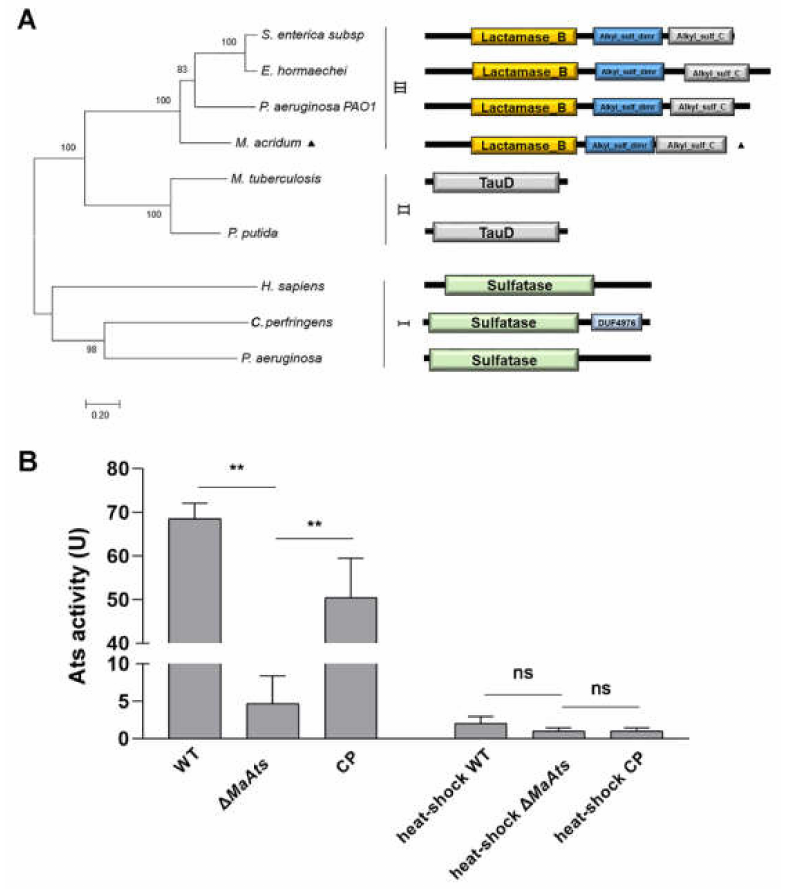
Figure 1. Features of MaAts in M. acridum . ( A ) Phylogenetic relationships of sulfatase proteins from bacteria, fungi, human. S. enterica subsp : Salmonella enterica subsp (EDZ09460.1); E. hormaechei : Enter- obacter hormaechei (CBK85007.1); P. aeruginosa PAO1: Pseudomonas aeruginosa PAO1 (SKC13380.1); M. acridum : Metarhizium acridum (EFY85493.1); M. tuberculosis : Mycobacterium tuberculosis